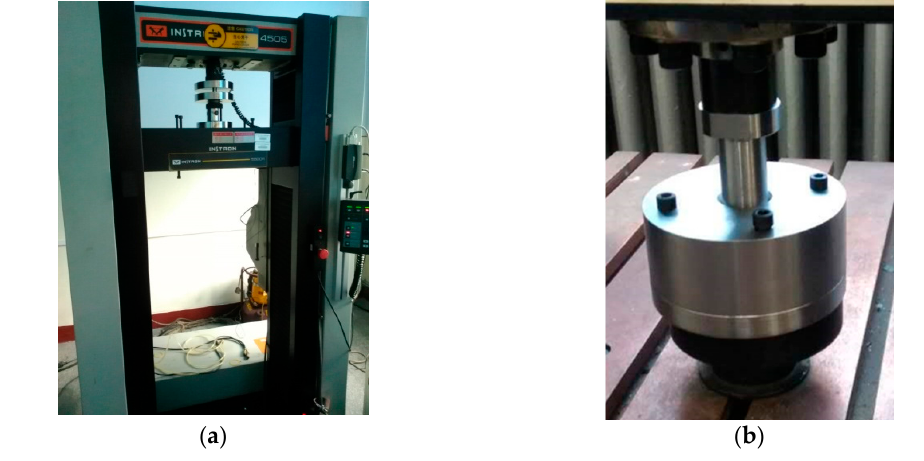
Figure 9. ( a ) Instron 5500R load frame device [29]; ( b ) Spherical indenter.